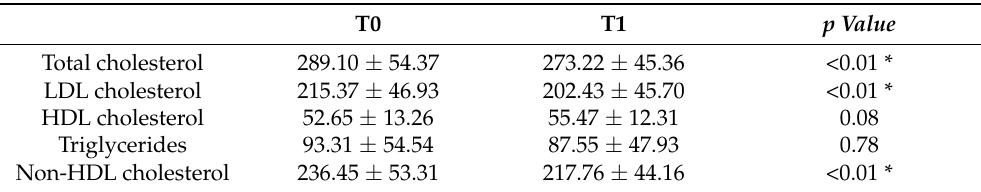
Table 5. Lipid profile of the study population without positive family history for CHD ( n = 49) at baseline (T0) and after nutritional and lifestyle intervention